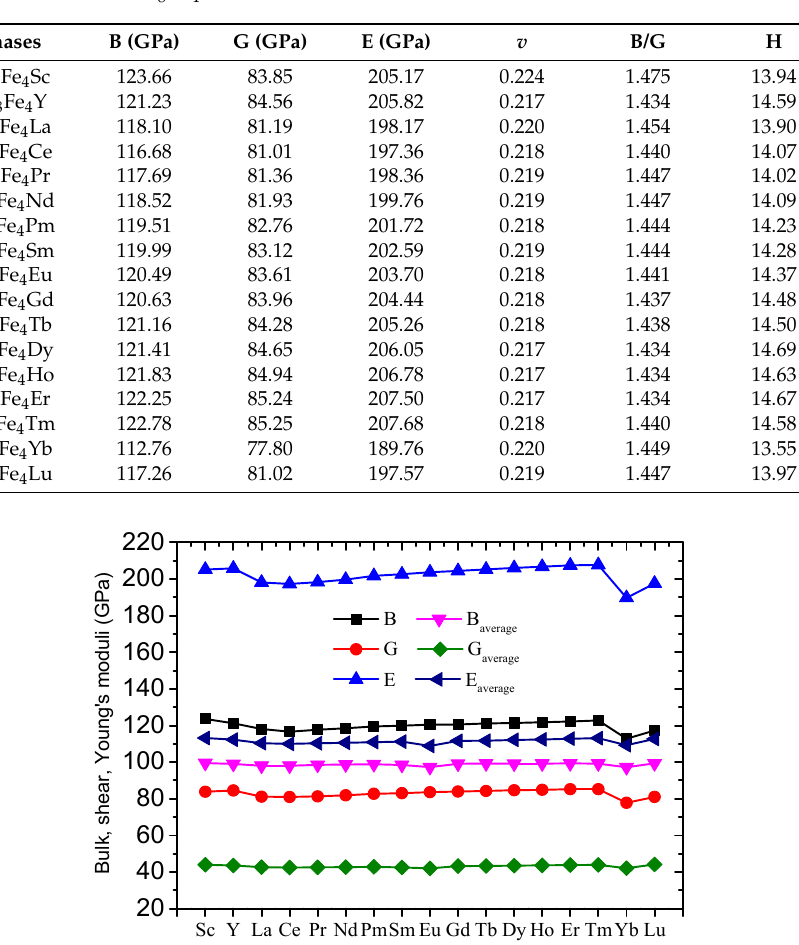
Figure 1. The calculated bulk, shear, and Young’s modulus of Al 8 Fe 4 RE IMCs.